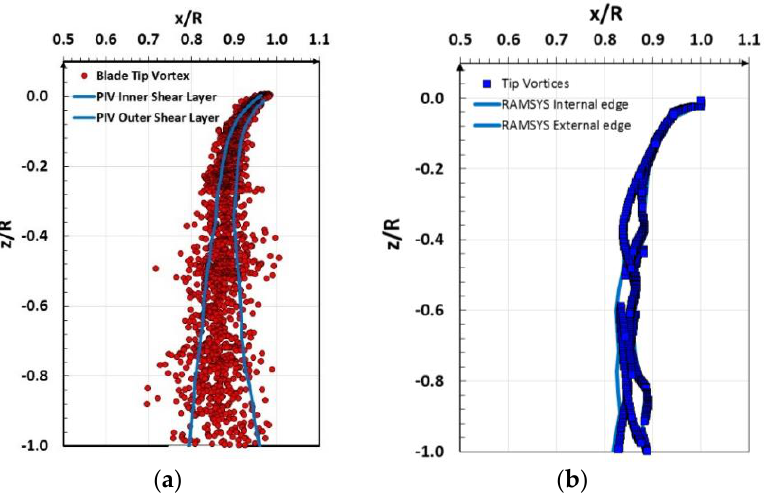
Figure 13. PIV ( a ) and numerical ( b ) position of blade tip vortices with respect to the shear layer region.